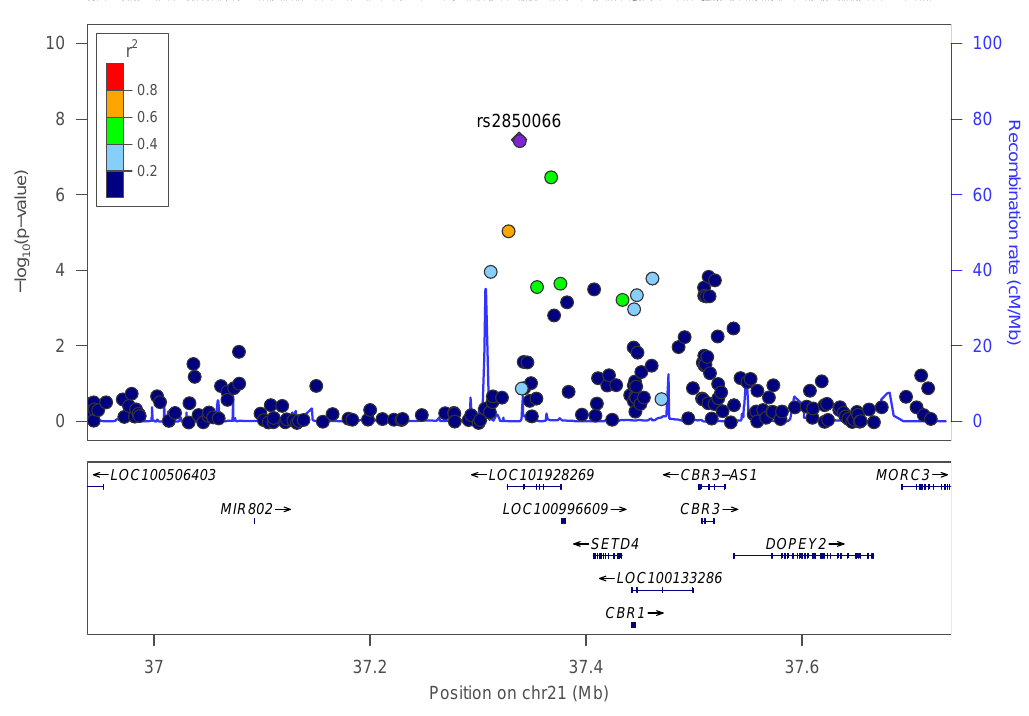
Figure 5. Regional plot for the SNP rs280066, located in the LOC101928269 gene, on chromosome 21 in the GWAS, for adiponectin concentrations in non-diabetic subjects. p -values obtained in the general linear regression model adjusted for sex, age and